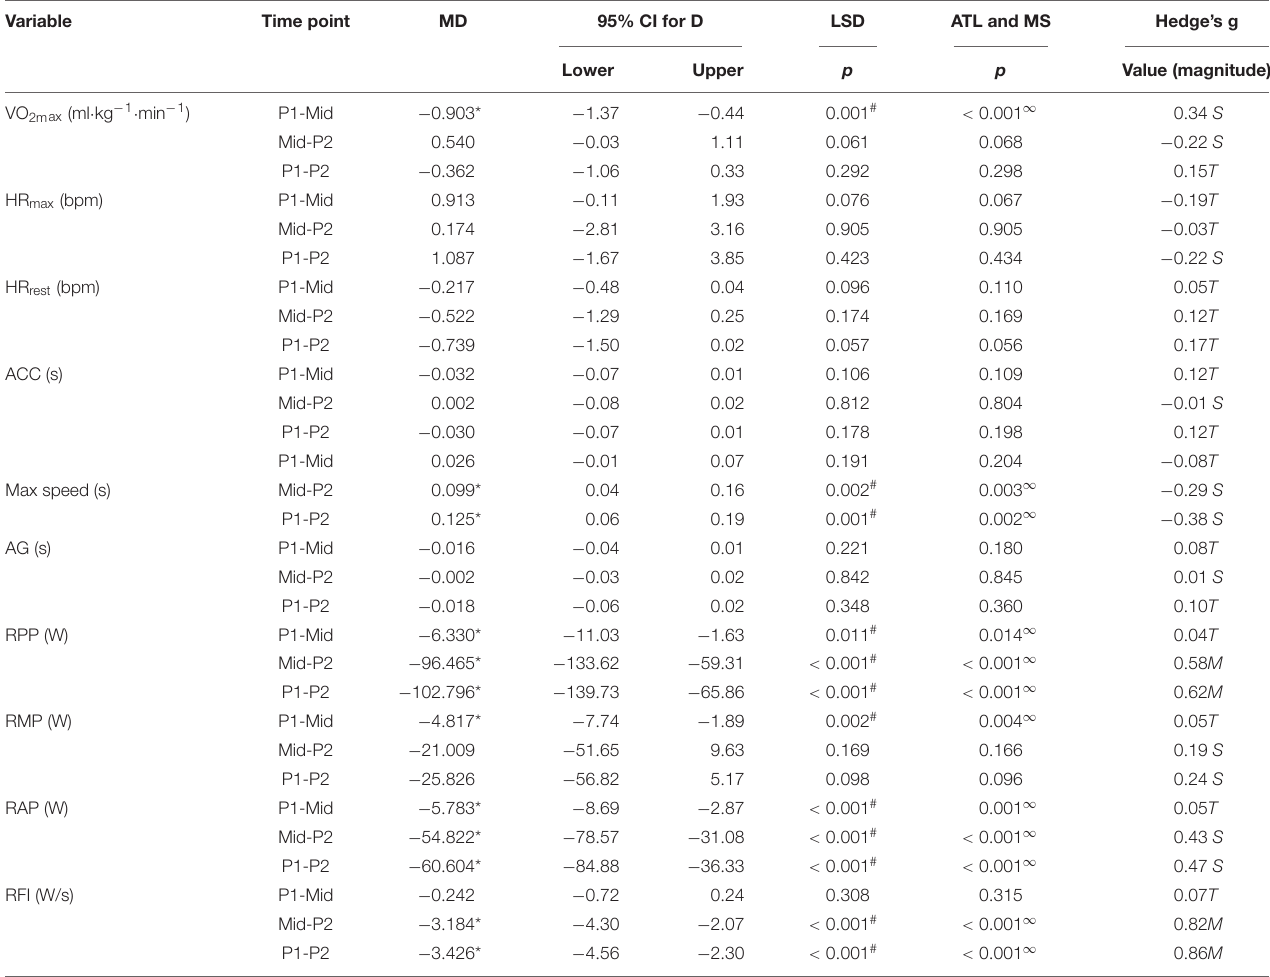
TABLE 4 | Accumulated training load and maturation status data for fitness tests in relation to different time points and pairwise comparisons.